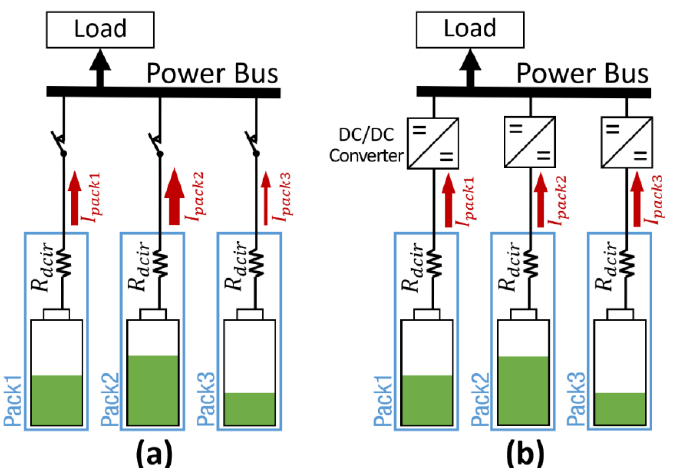
Figure 14. ( a ) The different amounts of current on each battery pack due to the different pack voltage. ( b ) The use of DC/DC converters to achieve an optimal equal current sharing.